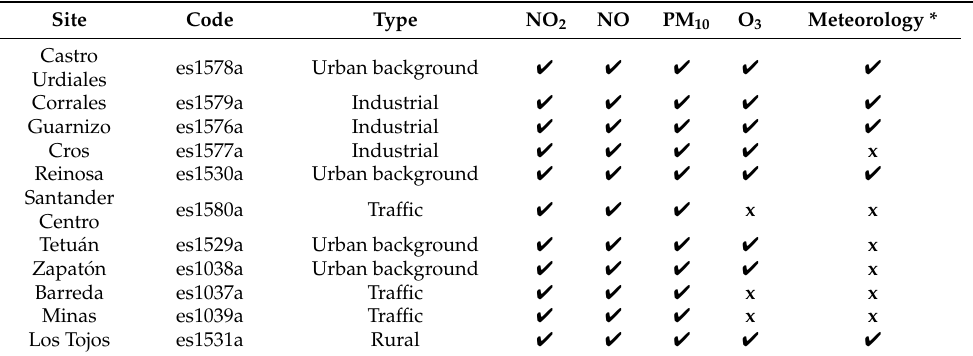
Table 1. Names, codes, type and monitored parameters of the air quality monitoring sites used in the